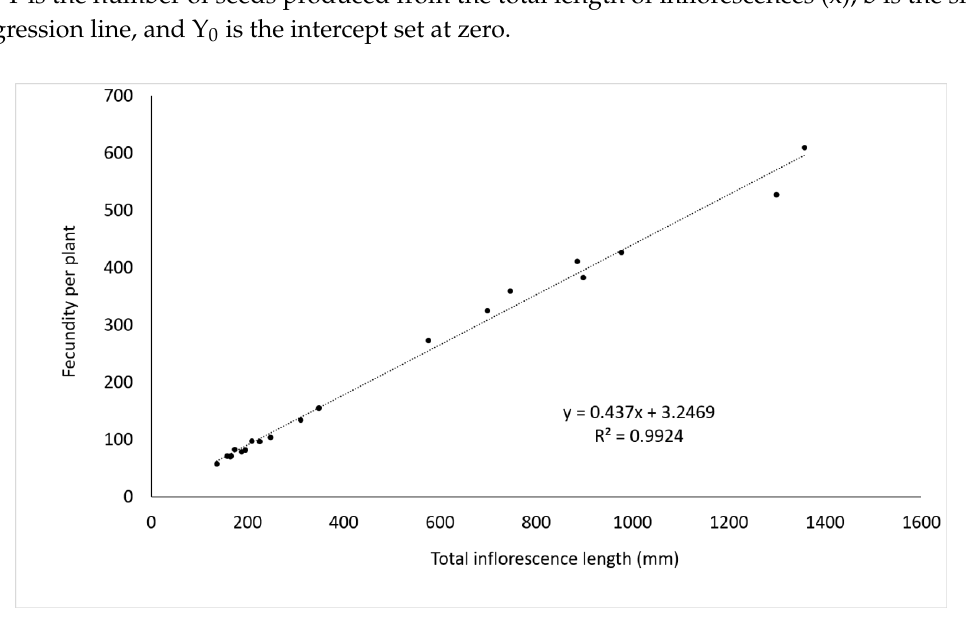
Figure 2. Relationship between total inflorescence length and fecundity per barley grass plant grown under greenhouse conditions at Wagga Wagga, NSW. Data are presented as a functional two-parameter linear model fitted to total inflorescence length and fecundity per plant (Figure 2, n = 20).